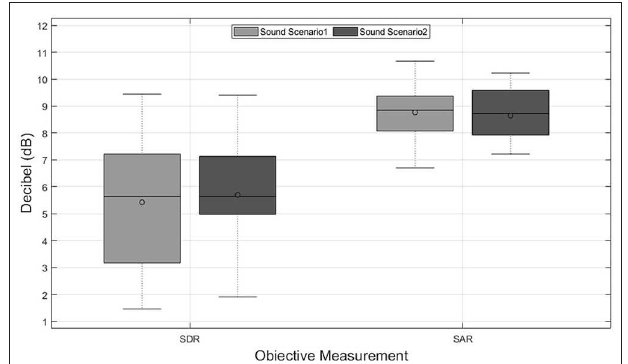
FIGURE 3 | Results of the objective instrumental measurements based on the signal-to-distortion-ratio (SDR) and the signal-to-artifacts-ratio (SAR) in decibels (dB) for two sound scenarios across music